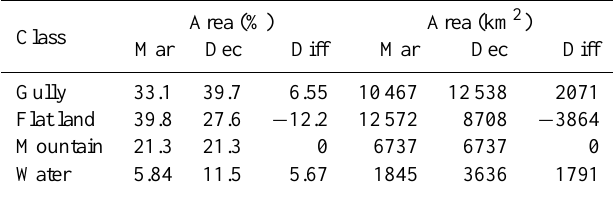
Table 8. Regional change of erosion area as indicated the differ- ence (diff) in area percentage (%) or in km 2 between March and December 2006 for the four land cover